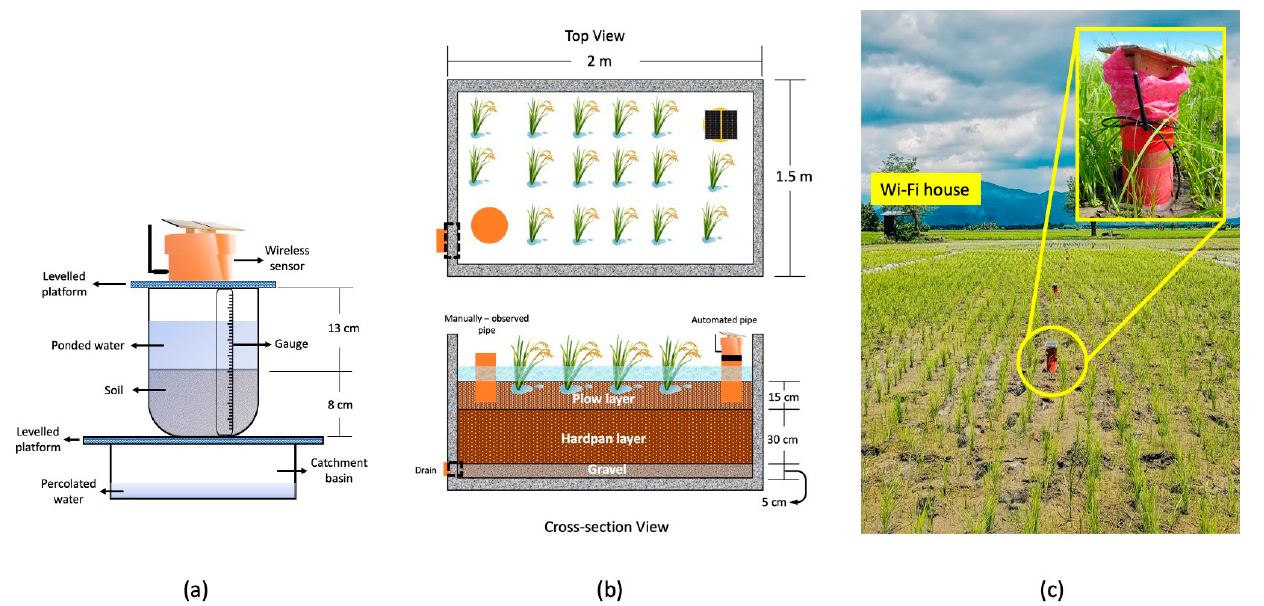
Figure 6. Experimental setup of the sensor testing under ( a ) laboratory condition, ( b ) pseudo-field condition, and ( c ) actual field condition.